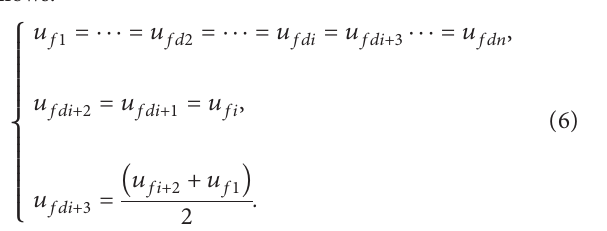
Table 1: The relationship among x